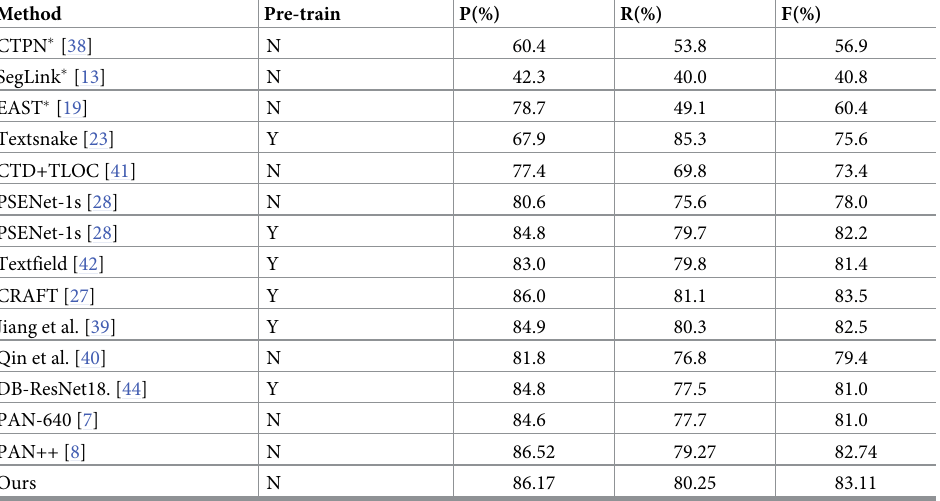
Table 4. Results at 640 × 640 on CTW1500, pre-train represents whether to use the pre-training dataset for fine- tuning. “Y” means using pre-training, “N” means not using pre-training. “P”, “R” and “F” stand for “precision”, “recall” and “F-measure” respectively. � indicates the results from [7]. PAN++ [8] is the detection